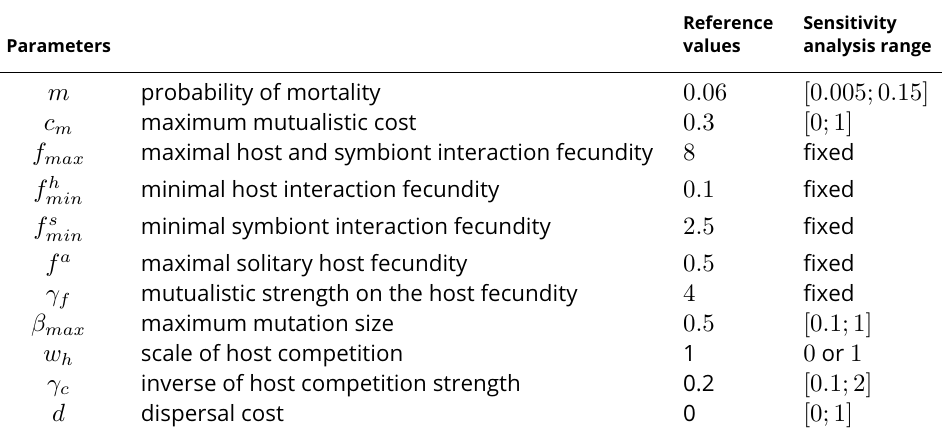
Table 1. List of parameters and their reference values used for the simulations. The parameters of host and symbiont fecundities are determined to ensure the viability of the antagonistic system, therefore they are fixed because they are constitutive of the